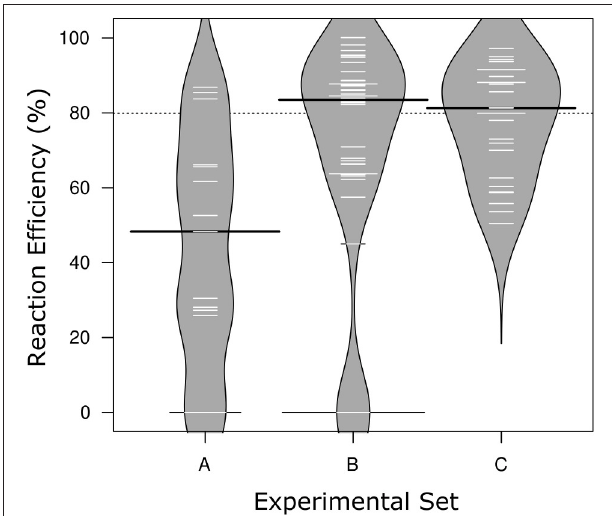
FIGURE 1 | Distribution of reaction efficiencies across the three Sets of MFQPCR assay conditions. Higher primer concentrations in Sets B & C corresponded with improved efficiencies, and exclusion of primers with inosines corresponds with the elimination of failed/zero efficiencies in Set C. Further differences in assay conditions are outlined in Table 2 . Black lines show the medians; white lines represent mean efficiency score of individual assays (n = 15, 48, 27, respectively); polygons represent the estimated density of the data. Efficiencies are based on standards